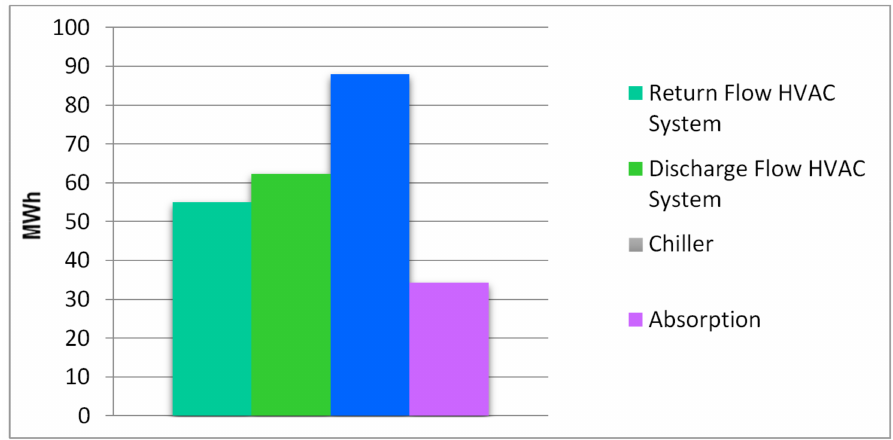
Figure 14. Distribution of cooling systems (fans and pumps).